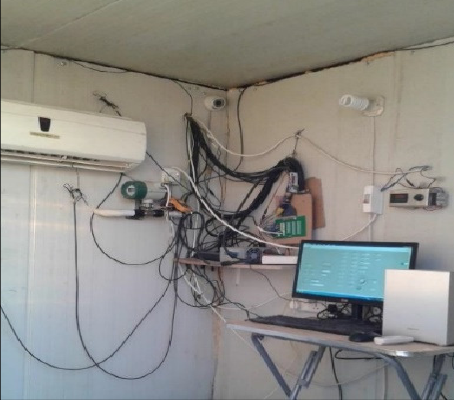
Fig. 2. Indoor unit and control system.